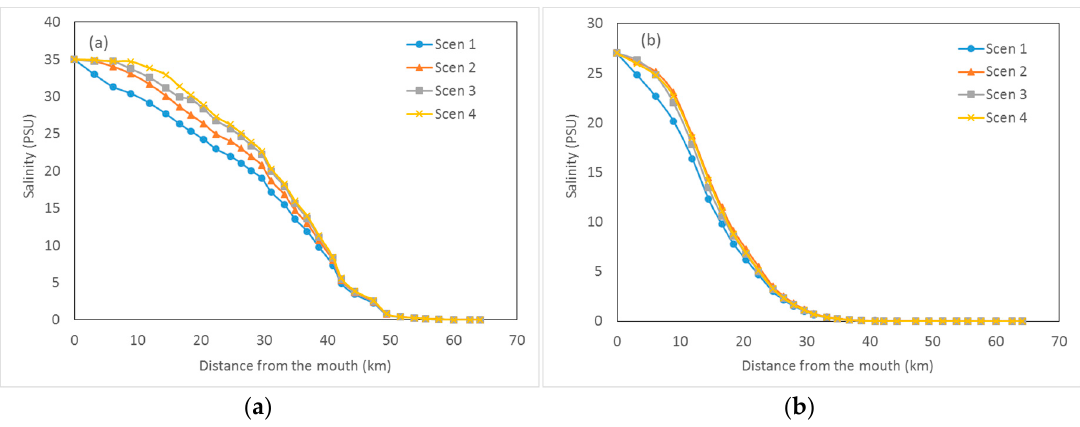
Figure 12. Salinity distribution at center line of cross section along the river from the mouth to upstream during spring tide ( a ) and neap tide ( b ).